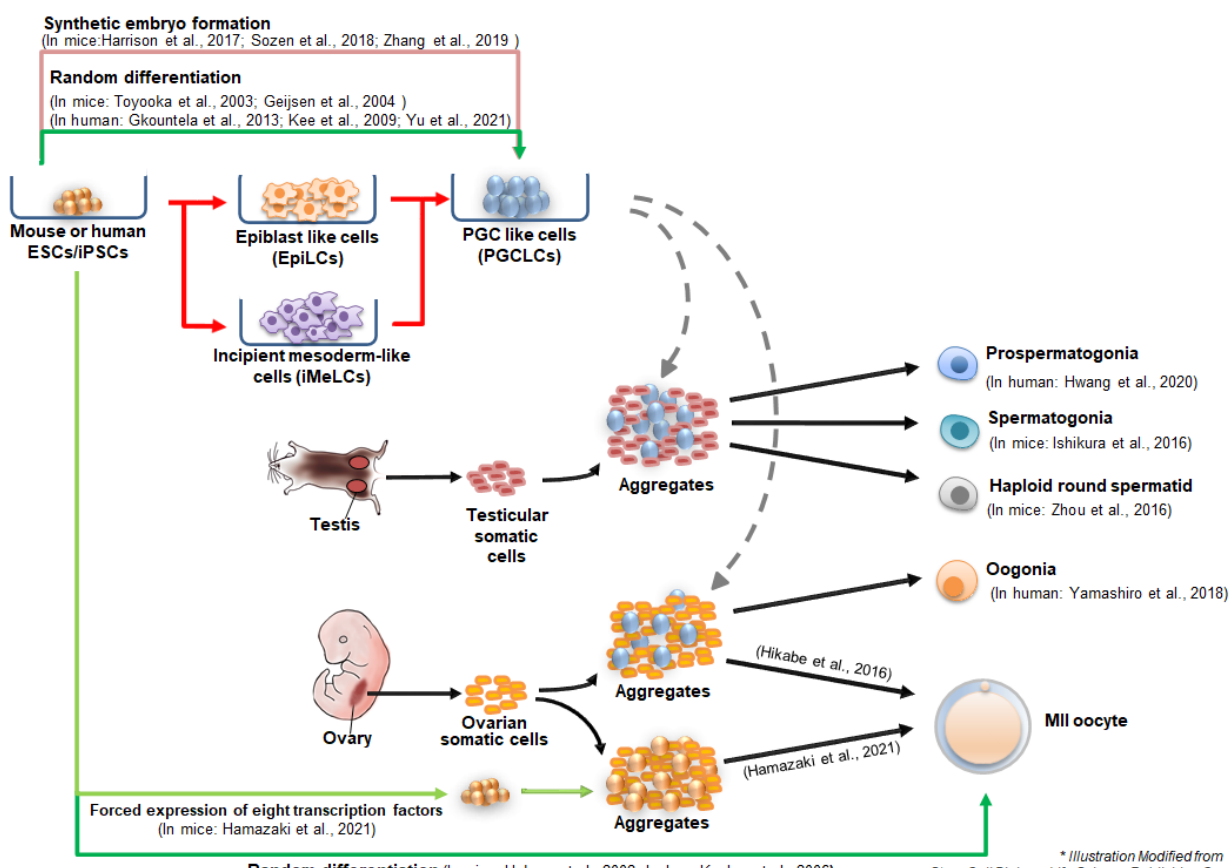
Figure 2. Approaches for the derivation of male and female germ cells from PSCs in vitro. PGCLCs can be derived via random differentiation, synthetic embryo formation, EpiLCs, or iMeLCs. A two-step differentiation method is the standard protocol to generate (pro)spermatogonia or mature germ cells (spermatids and MII oocytes). Modified from Stem Cell Biology, Life Science Publishing Co. [27].